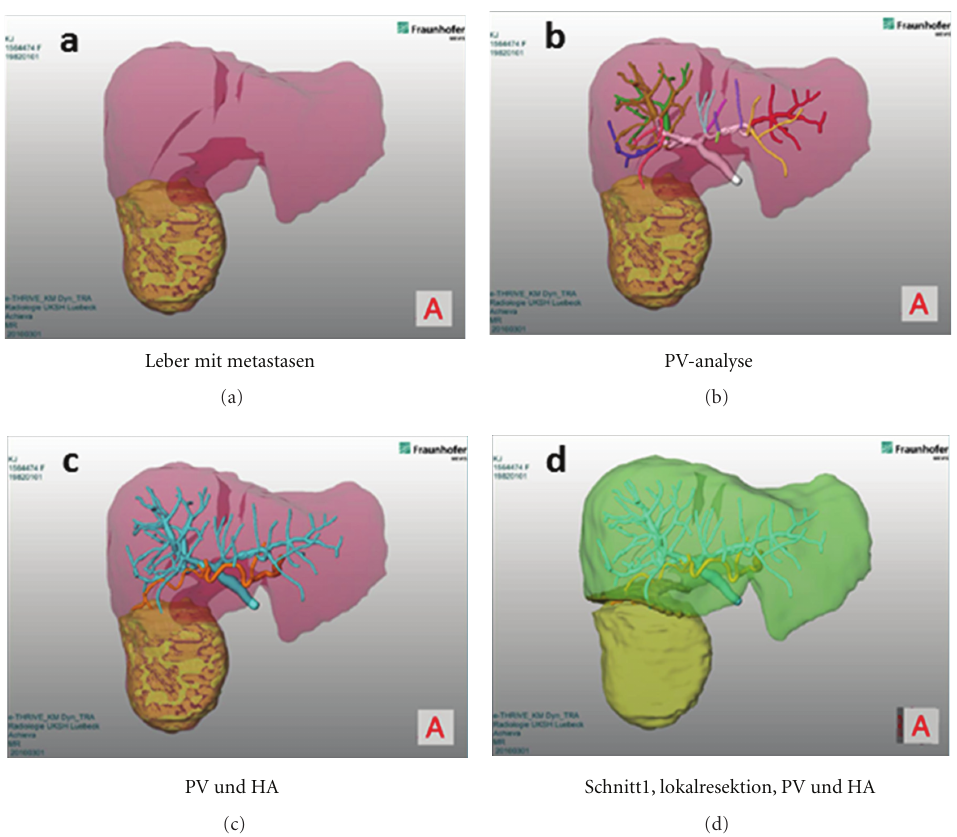
Figure 1: 3D MeVis data. (a) liver anatomy and tumor, (b) liver anatomy and portal veins, (c) liver anatomy, portal veins, and hepatic arteries, (d) potential resection